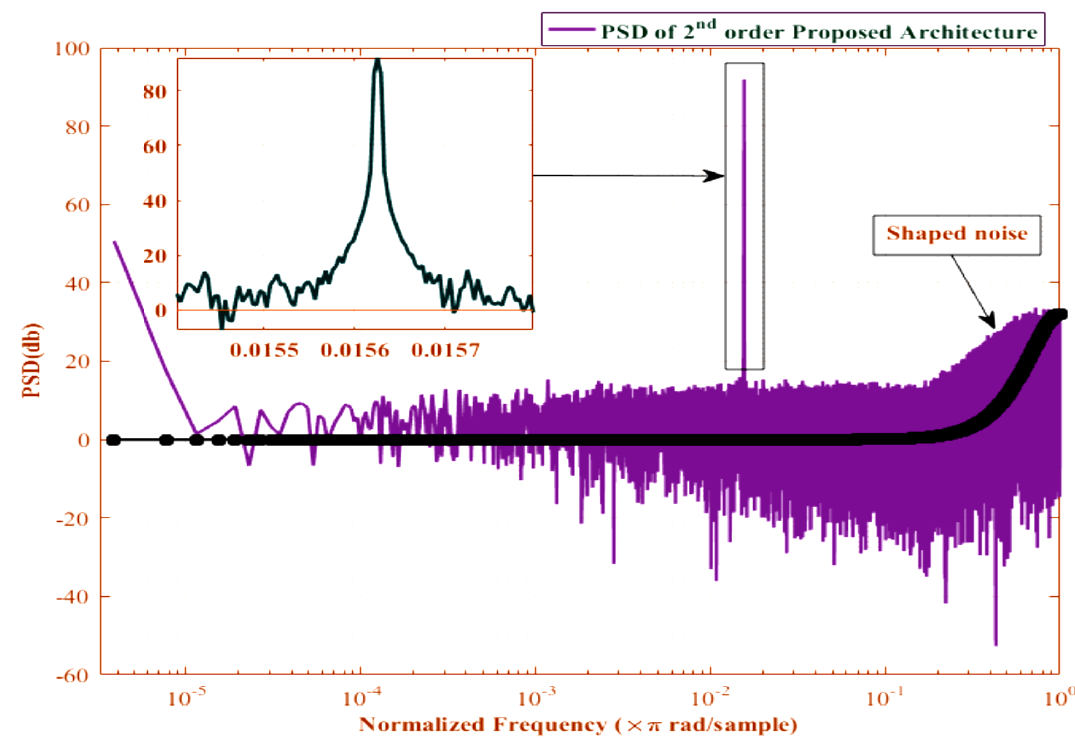
Figure 8. PSD of Hybrid MASH-EFM Architecture with OSR = 64 .